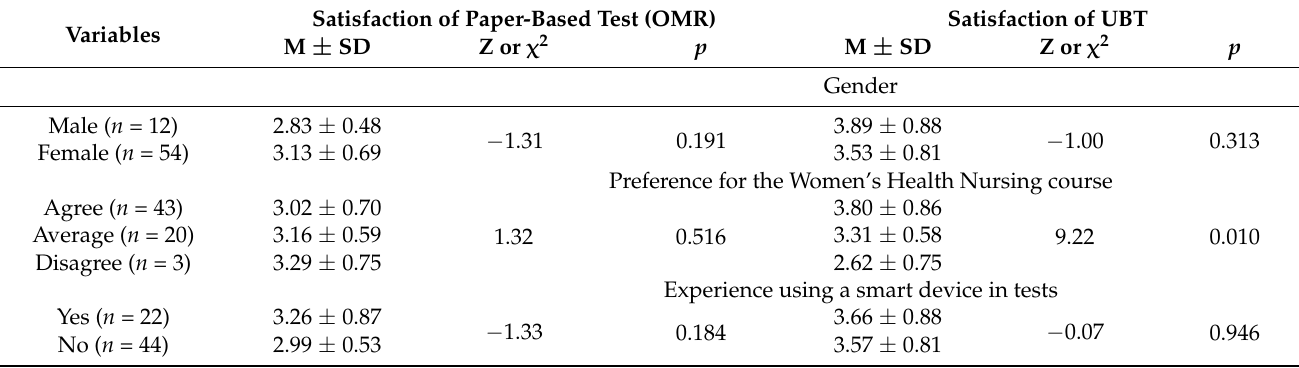
Table 4. Comparison of midterm exam paper-based test and final exam UBT according to general characteristics ( n = 66). Satisfaction of Paper-Based Test (OMR) Satisfaction of Variables